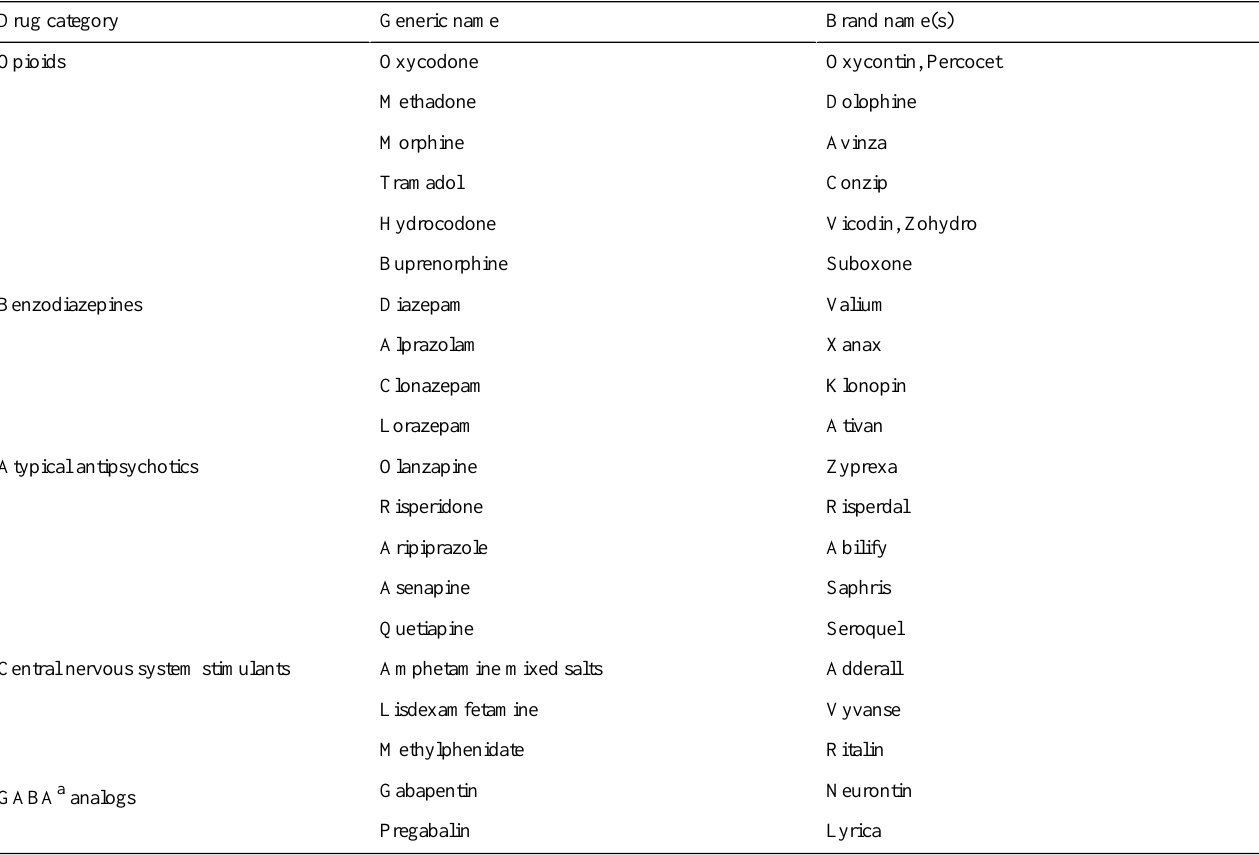
Table 1. Main drug categories, generic names, and brand names for prescription medications included in this study.